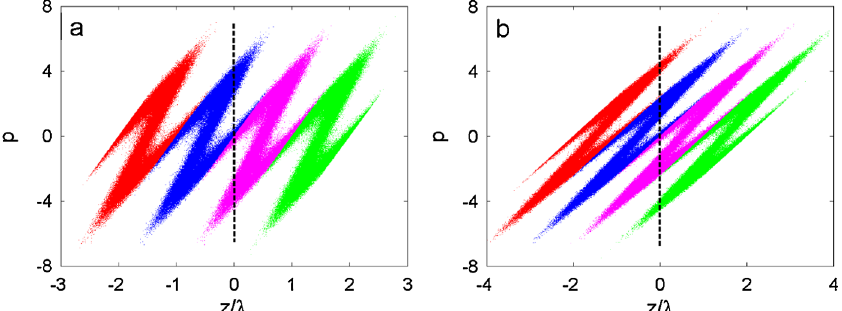
FIG. 4. (Color) Longitudinal phase space after beam passing through a dispersion section with strength (a) R 56 (cid:1) E=E ¼ (cid:6) , and (b) R 56 (cid:1) E=E ¼ 2 (cid:6)